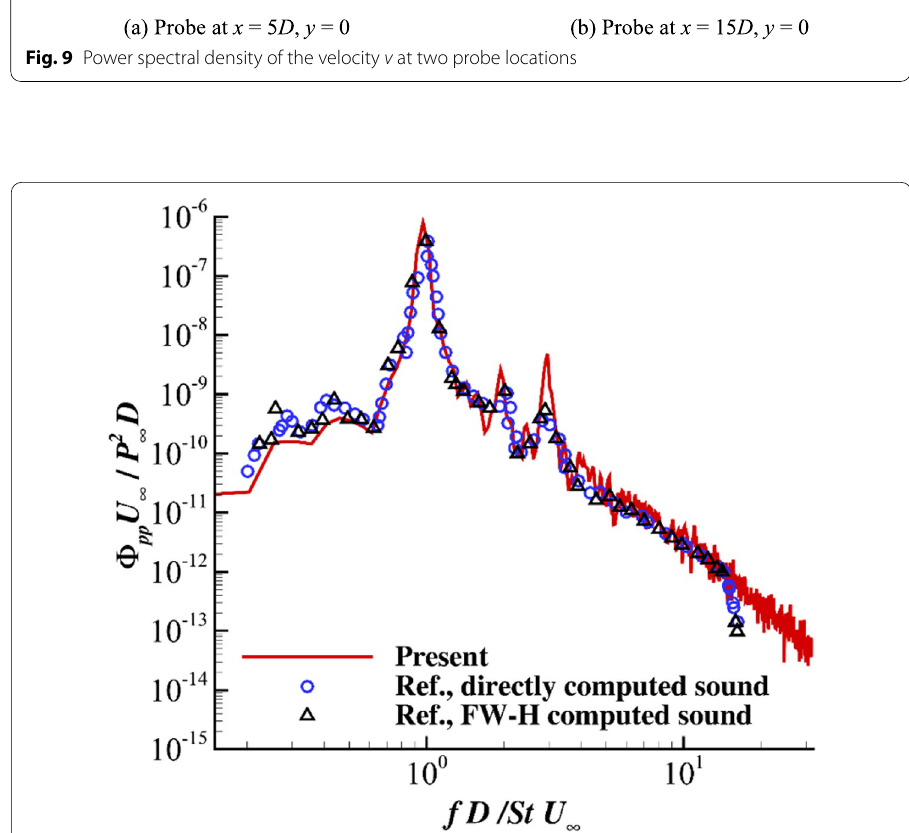
Fig. 10 Sound spectrum of an observer located at x